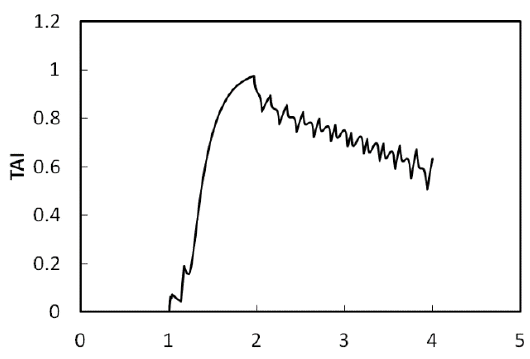
Figure 16. The TAI without control.